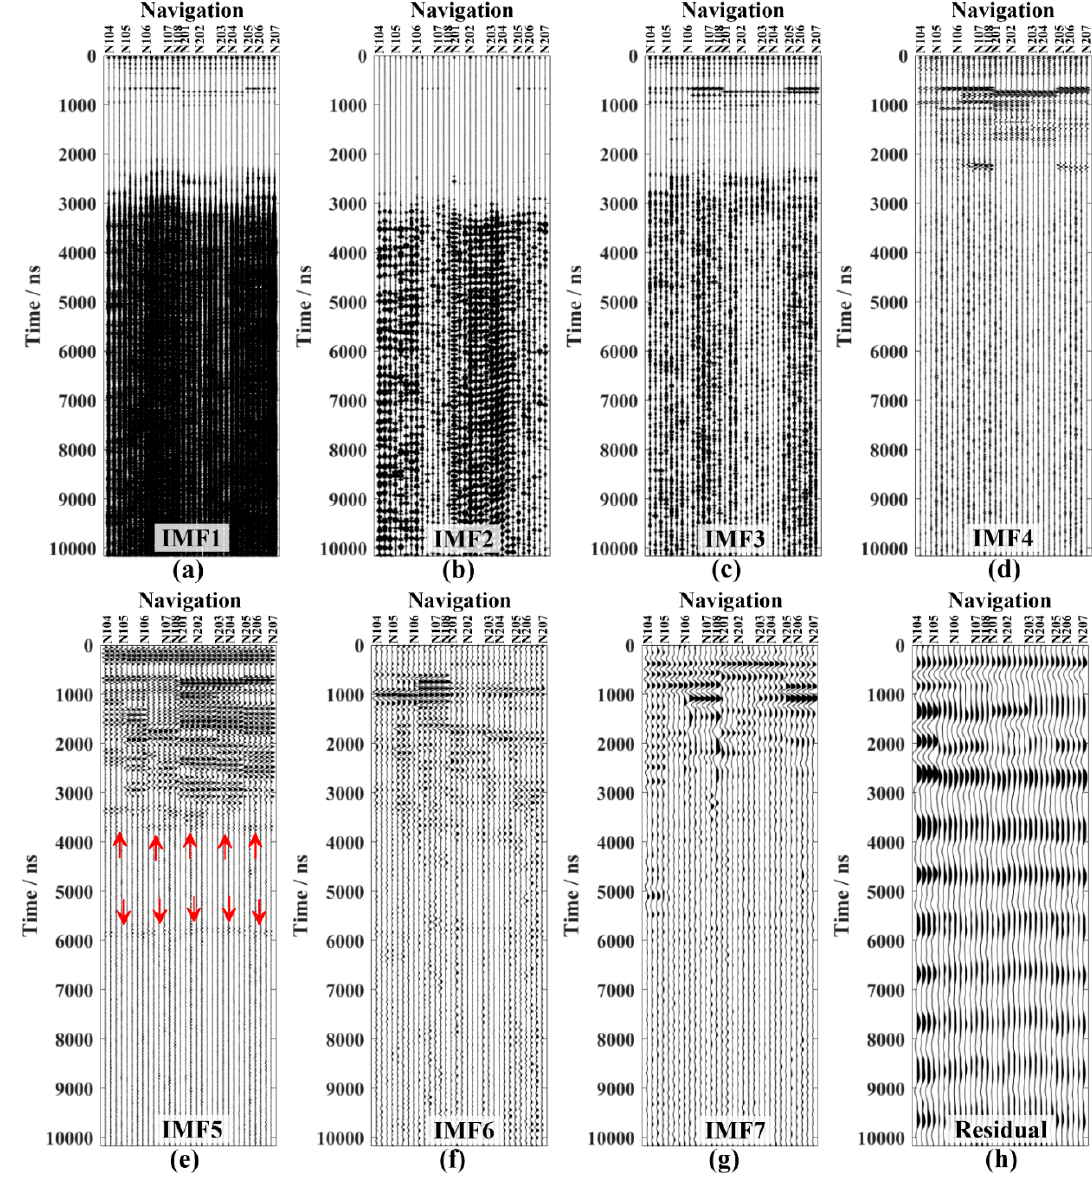
Figure 11. IMFs of stagnation points’ traces in Figure 7. ( a ) IMF1. ( b ) IMF2. ( c ) IMF3. ( d ) IMF4. ( e ) IMF5. ( f ) IMF6. ( g ) IMF7. ( h ) Residual.